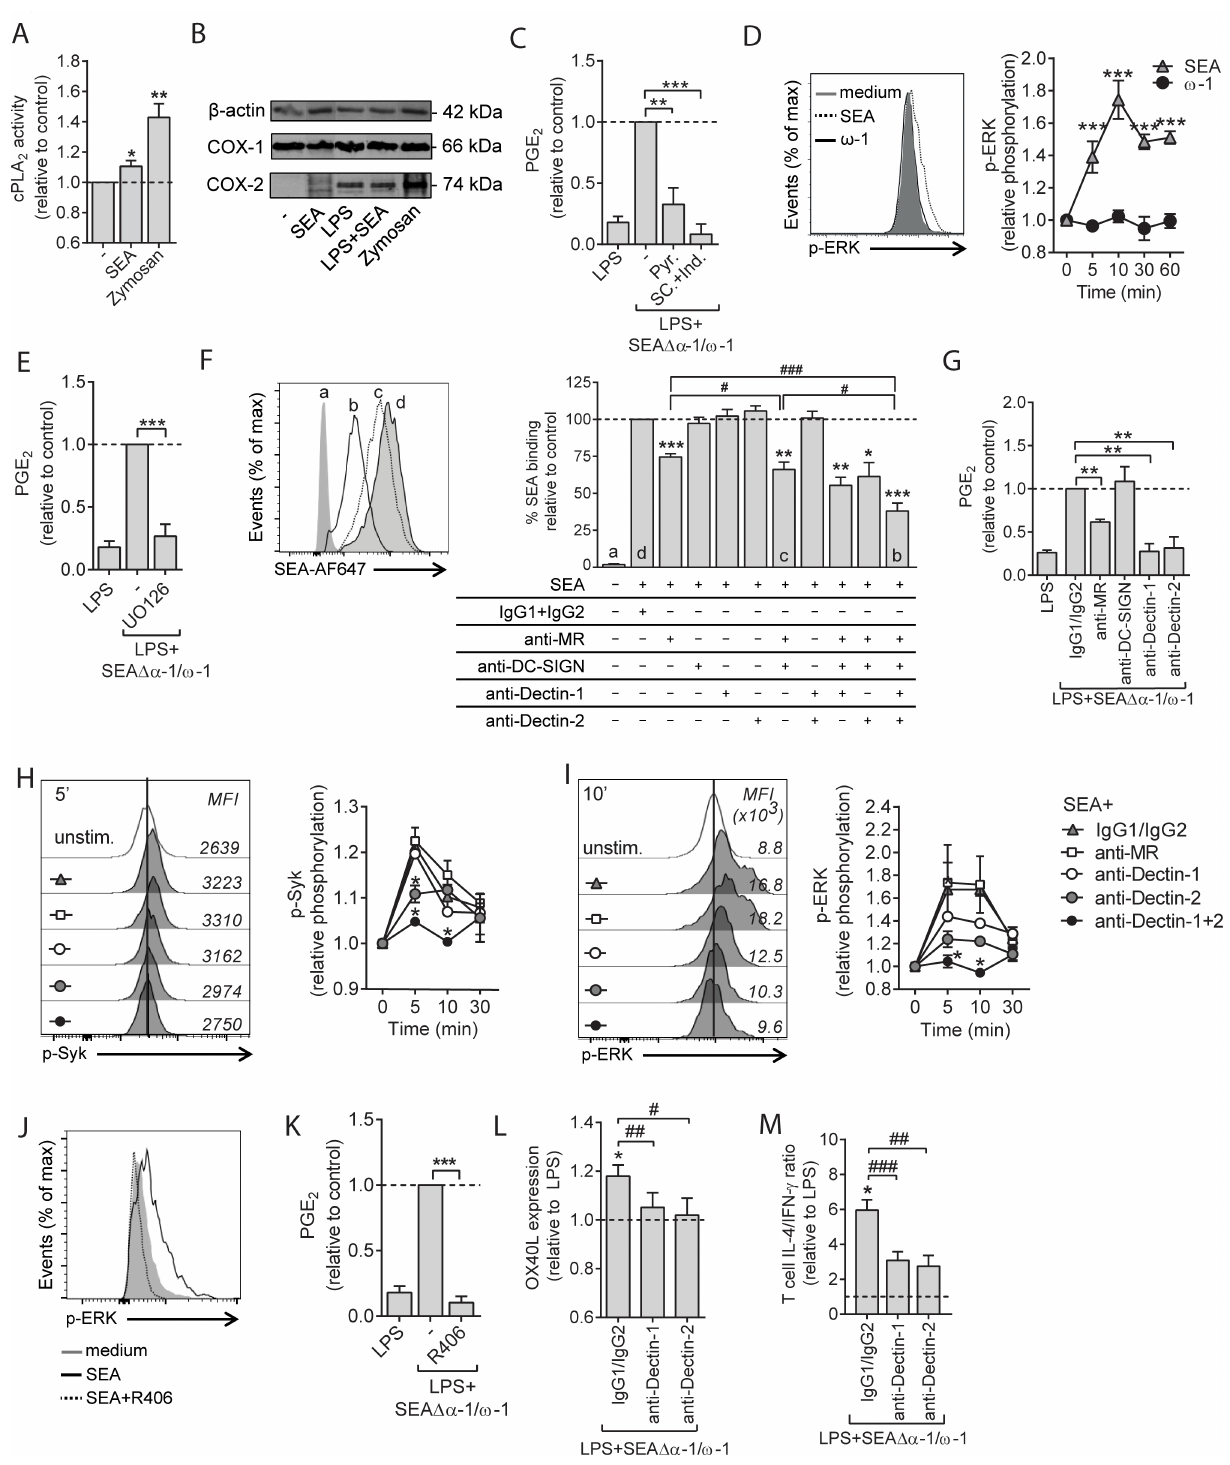
Fig 4. SEA promotes PGE 2 synthesis and drives Th2 polarization via signaling through Dectin-1 and Dectin-2 in human moDCs. (A) cPLA 2 activity 8 h after stimulation. Zymosan was taken along as a positive control for cPLA 2 activation. (B) Protein expression of COX-1 and COX-2 were assessed by western blot. β -actin was used as housekeeping protein. One of 3 experiments is shown. (C) Following 1 h pre-incubation with specific inhibitors for cPLA 2 (Pyr.) or COX-1 and COX-2 (SC and ind., respectively), moDCs were stimulated for 12 h with LPS plus SEA Δα -1/ω-1, and supernatants were collected for PGE 2 determination by LC-MS/MS. (D) At the indicated time points after stimulation with depicted stimuli, phosphorylation of ERK was